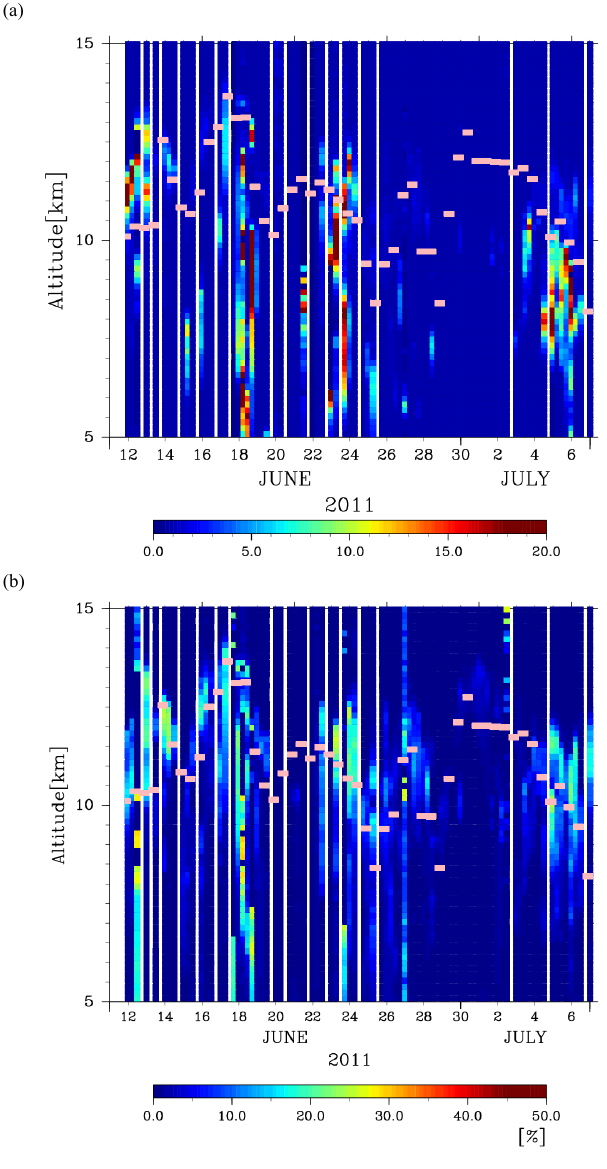
Figure 3. Vertical and temporal cross section of the backscattering ratio (a) and the depolarization ratio (b) at 532nm. The light purple rectangles show tropopause